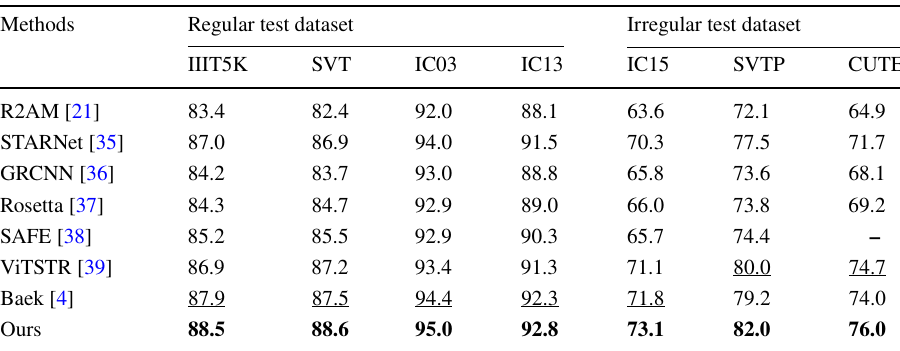
In each column, the best result is shown in bold font In each column, the second-best result is shown with an